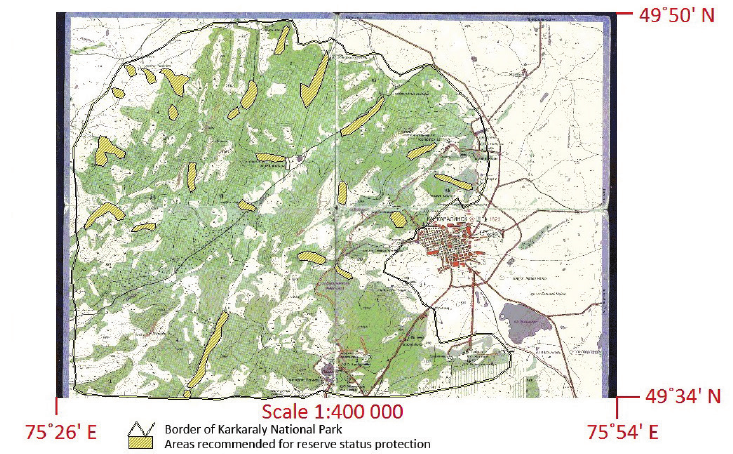
Figure 7. Existing protected territories and those that are recommended for protection in Karkaraly National